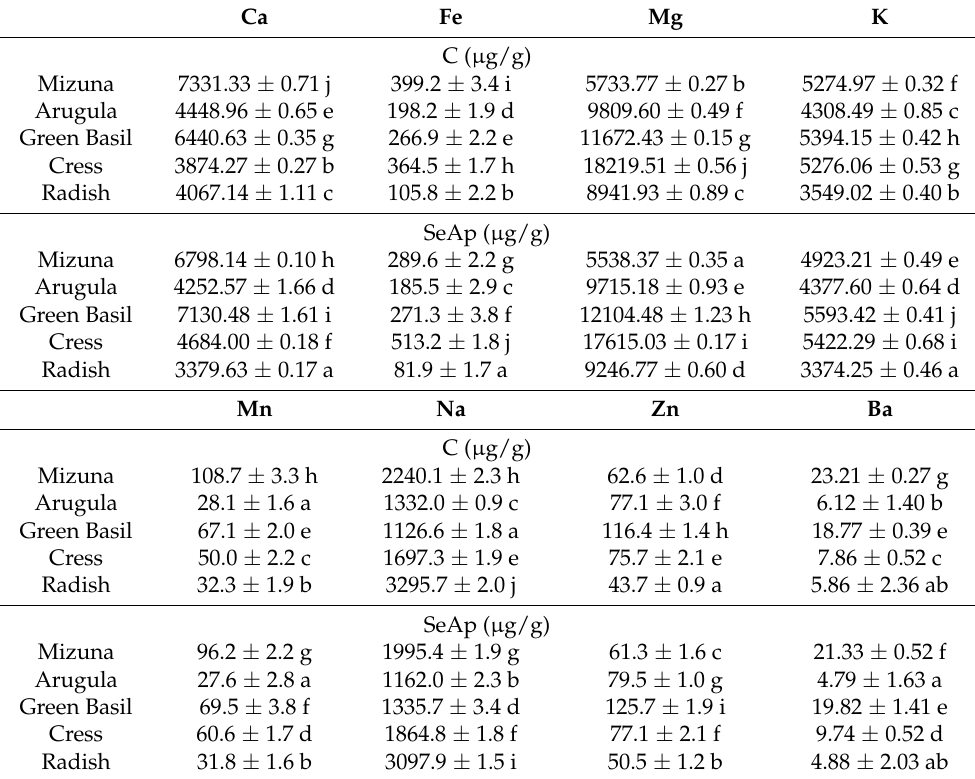
Table 6. Mineral elements content in dry weight (dw) in microgreens species after fortification with sodium